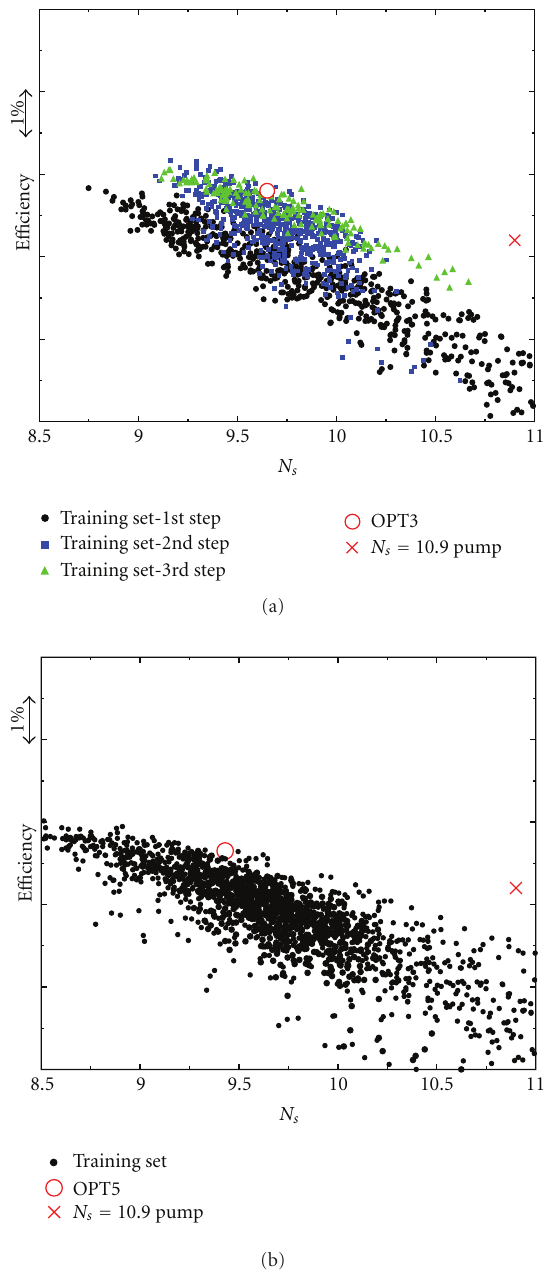
Figure 8: The optimization clouds: (a) 3-blade impeller, (b) 5-blade impeller.